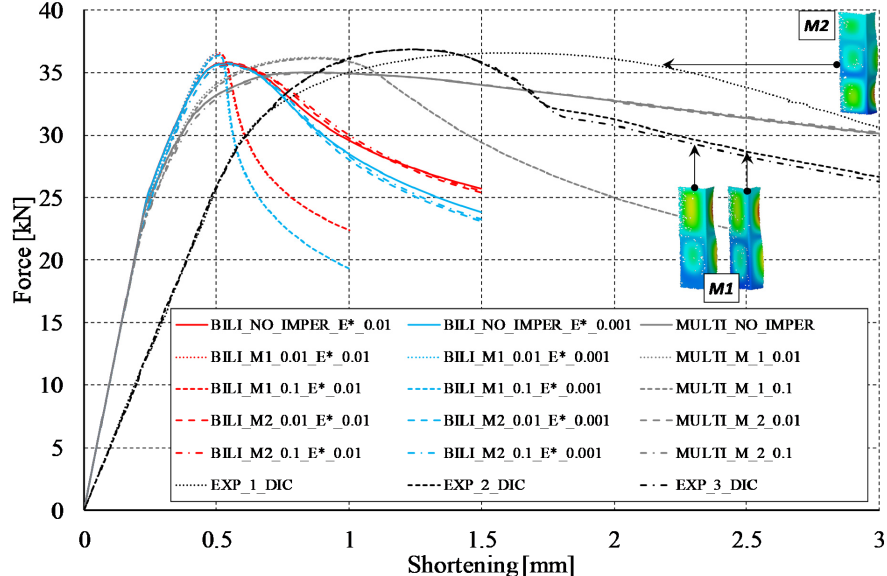
Figure 6. Experimental and numerical equilibrium paths of the considered channel section profile.